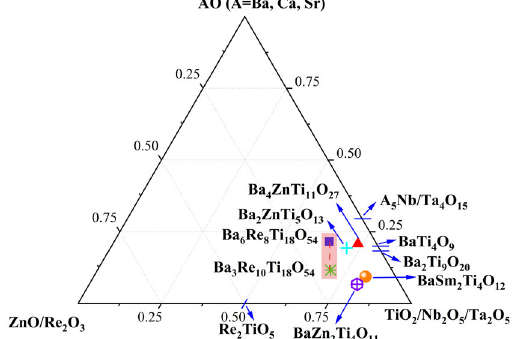
Fig. 15 Pseudo phase diagram of tungsten bronze structure and binary